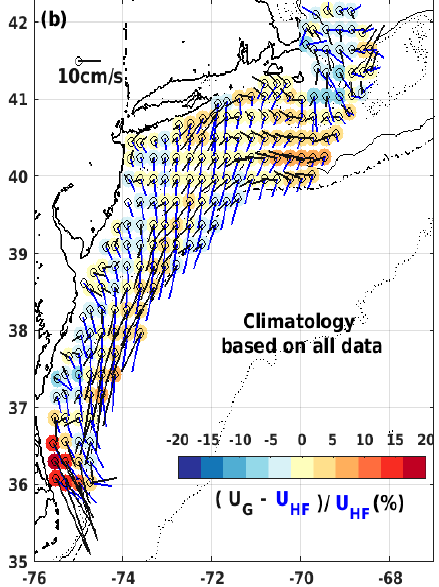
Figure 7. Graphical display of mean surface current vectors and their differences in the MAB: ( a ) GlobCurrent U GE00m ( b ) GlobCurrent U G (in black) and in situ HF radar U HF (in blue). The color scale indicates current magnitude percentage difference (in %) between ( a ) U GE00m , ( b ) U G and U HF . The 50-, 100-, 1000- and 4000-m isobath contours are also shown. Calculations are based on year-round data during the shared sampling time period from 2006 to 2016.